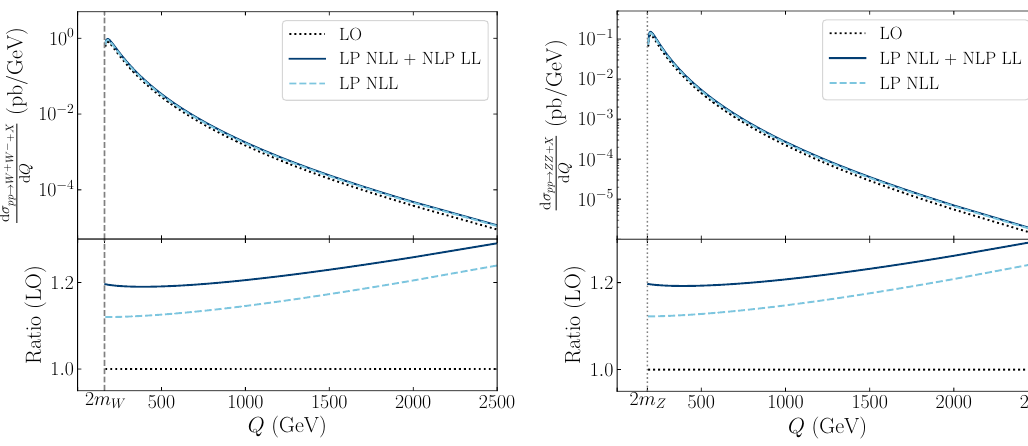
Figure 14. Differential cross section for W + W − production (left) and ZZ production (right) showing the LO (black dotted) and resummed LP NLL (dashed light-blue), and NLP LL + LP NLL (solid dark-blue) results. The scale µ is set to Q